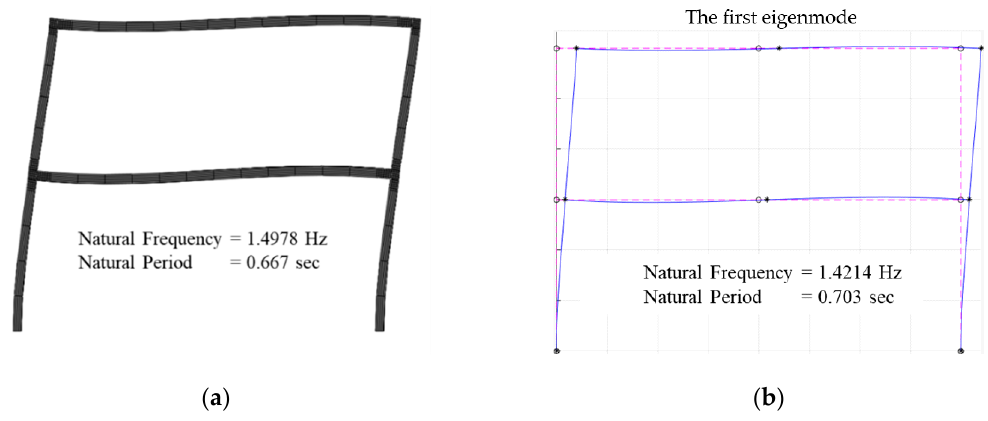
Figure 17. Structural natural frequency from ( a ) ABAQUS and ( b ) CALFEM/MATLAB.